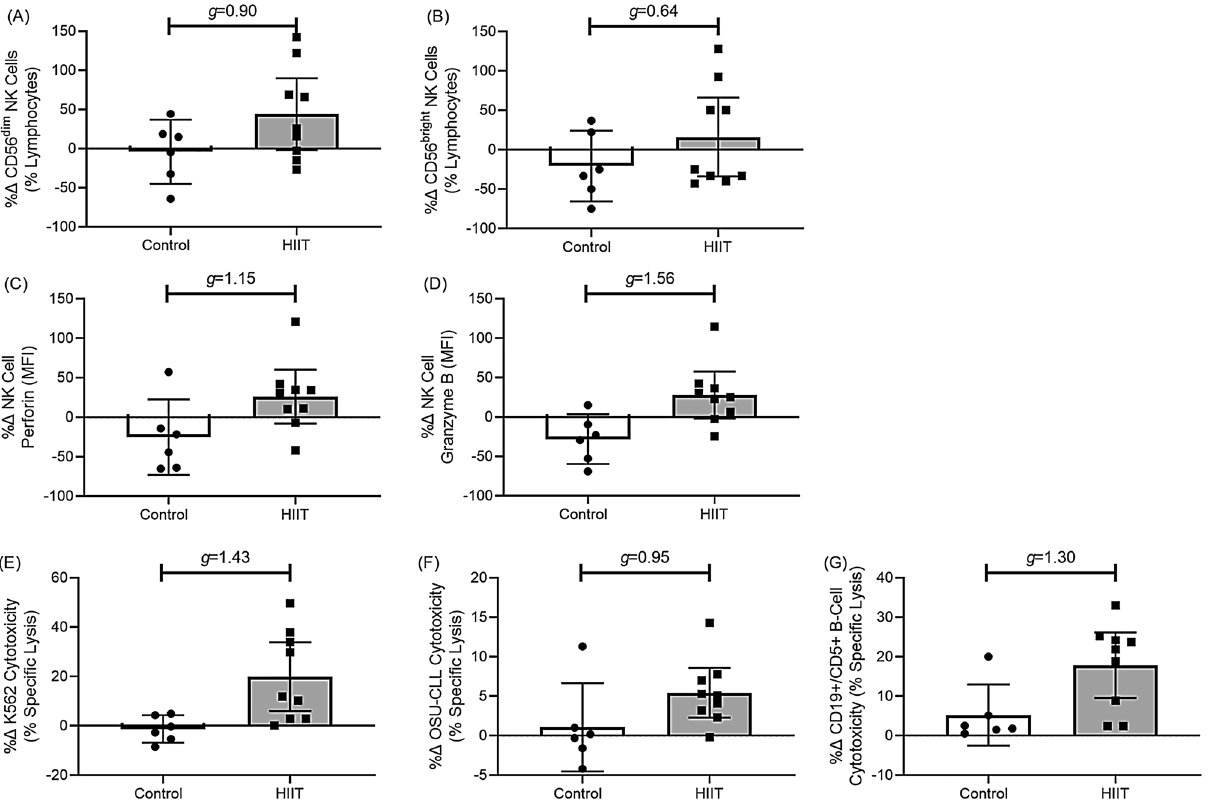
Figure 3. Mean (95% C.I.) percentage change (%∆) with Hedges G ( g ) group differences between HIIT and controls for CD56 dim NK-cell ( A ) and CD56 bright NK-cell ( B ) frequencies, expression (MFI) of NK-cell specific perforin ( C ) and granzyme B ( D ), and NK-cell cytotoxicity towards K562 ( E ), OSU-CLL ( F ), and autologous CD5 + B-cells ( G